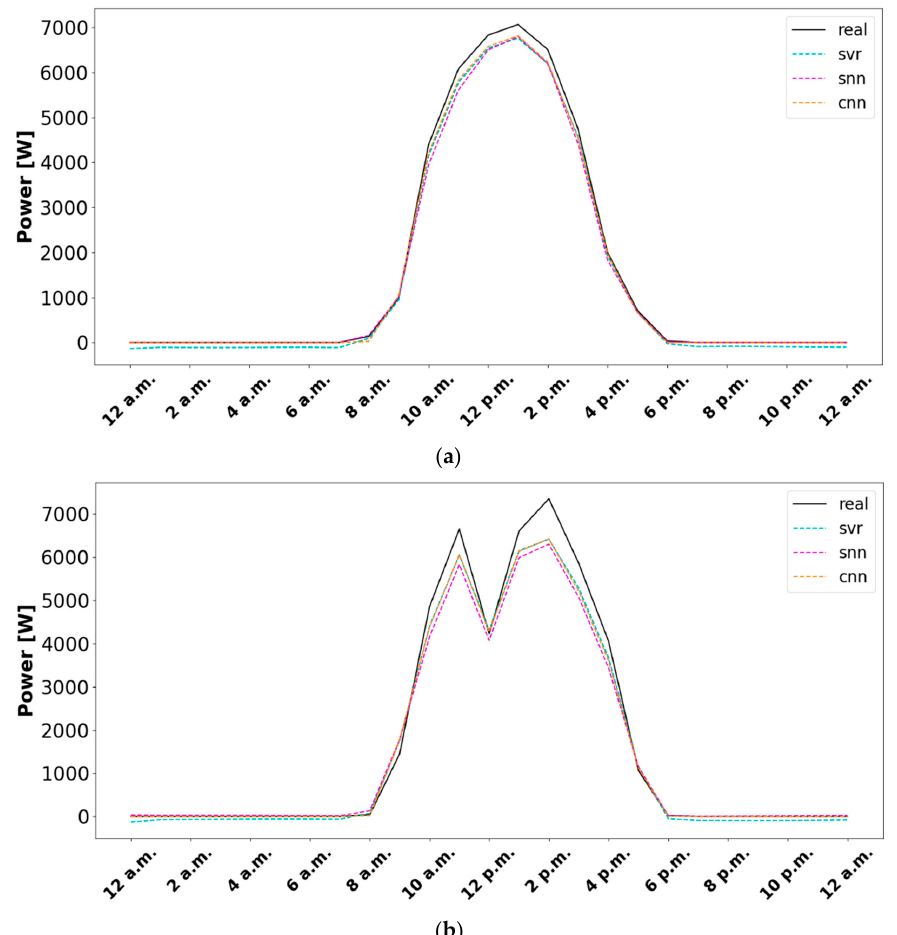
Figure 7. Adjustments corresponding to the test split of the SVR, SNN and CNN models in the forecast of photovoltaic production: ( a ) Forecast on a day with good conditions, ( b ) Forecast on a day with variant conditions.